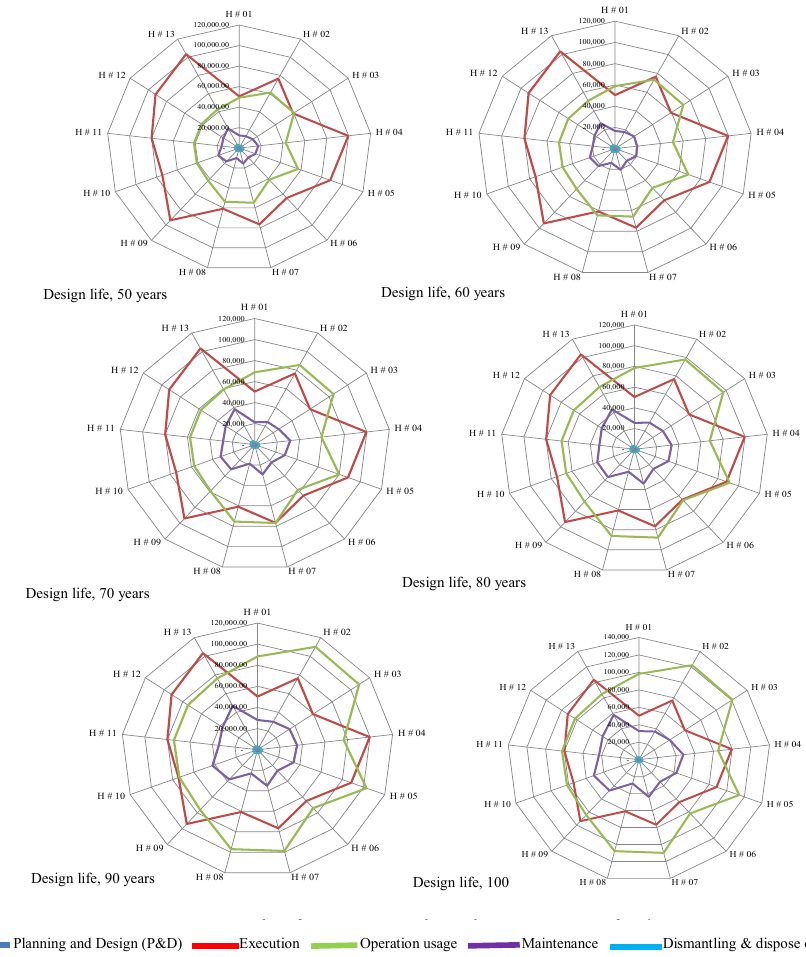
Fig. 8. Variation incontribution trend of each phase w.r.t time.